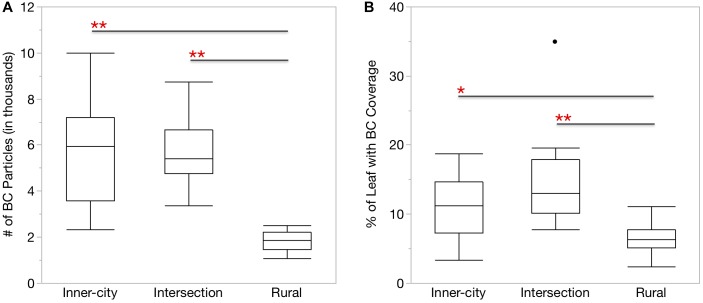
More BC particles were found on the surface of urban Platanus × hispanica leaves. Box plots show (A) the number of BC particles per mm2 leaf segment and (B) the percentage of the total leaf area covered by BC particles. ∗p < 0.01, ∗∗p < 0.0001. Box plots display the median, the first and third quartiles, and the maximum and minimum n = 18.